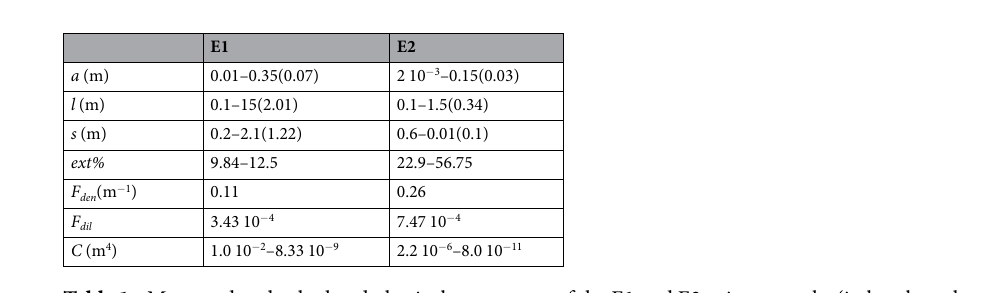
Table 1. Measured and calculated physical parameters of the E1 and E2 vein networks (in brackets the average